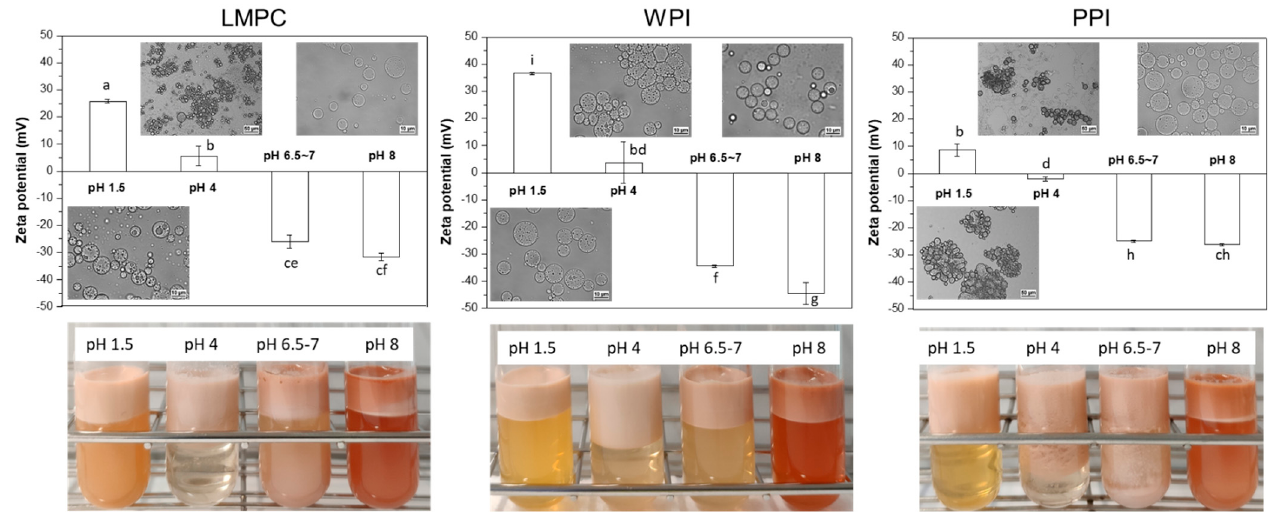
Figure 4. Effect of pH on zeta potential of W 1 /O/W 2 emulsions stabilized with LMPC, WPI and PPI after 14 days of incubation, and visual appearance of the emulsions. Insets show microstructure of the emulsions following adjustment to pH 1.5, 4.0, 6.5–7, and 8.0. Different letters on top of the bar mean significant differences at p < 0.05.